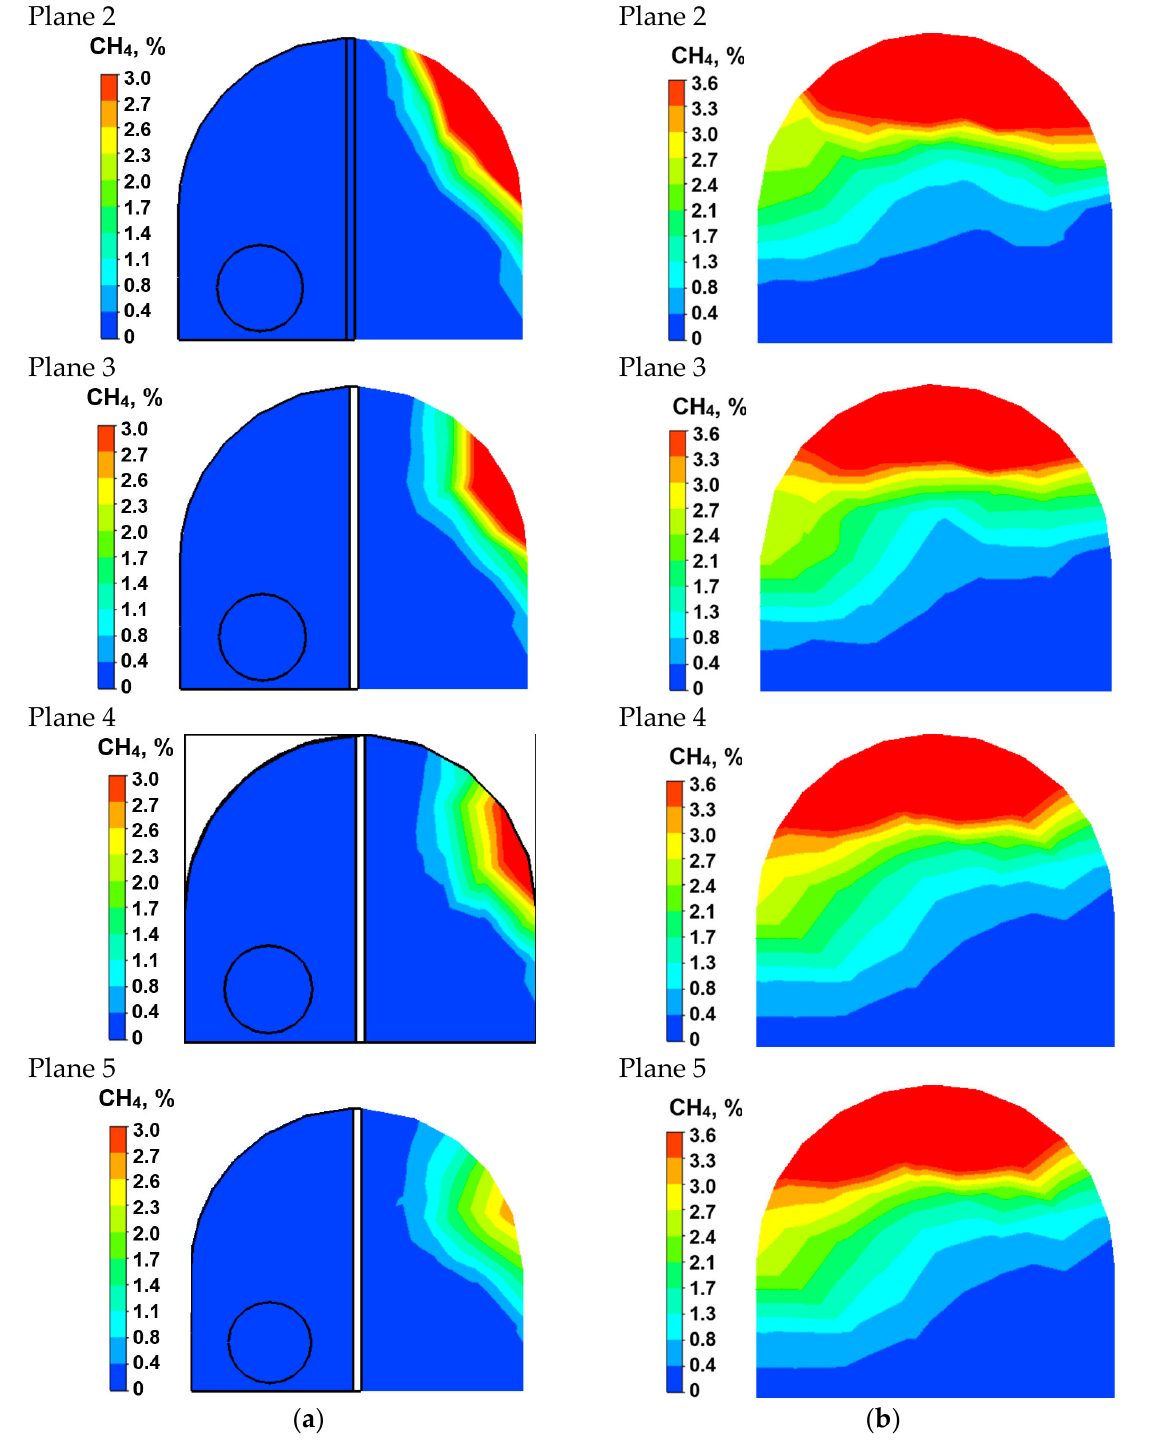
Figure 11. The distributions of methane concentrations in selected vertical sections (Planes 2–5) of the tailgate with built-in AVE ( a ) and without such equipment ( b ).